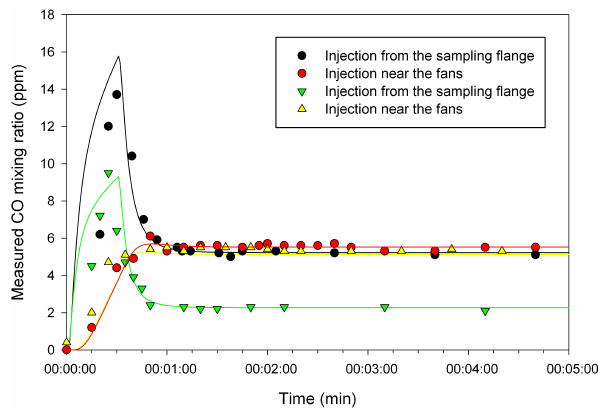
Fig. 3. Concentration-time evolution of CO near the sampling point after injection in the chamber from various injection ports. The lines are the results of the modeling for corresponding experiment.